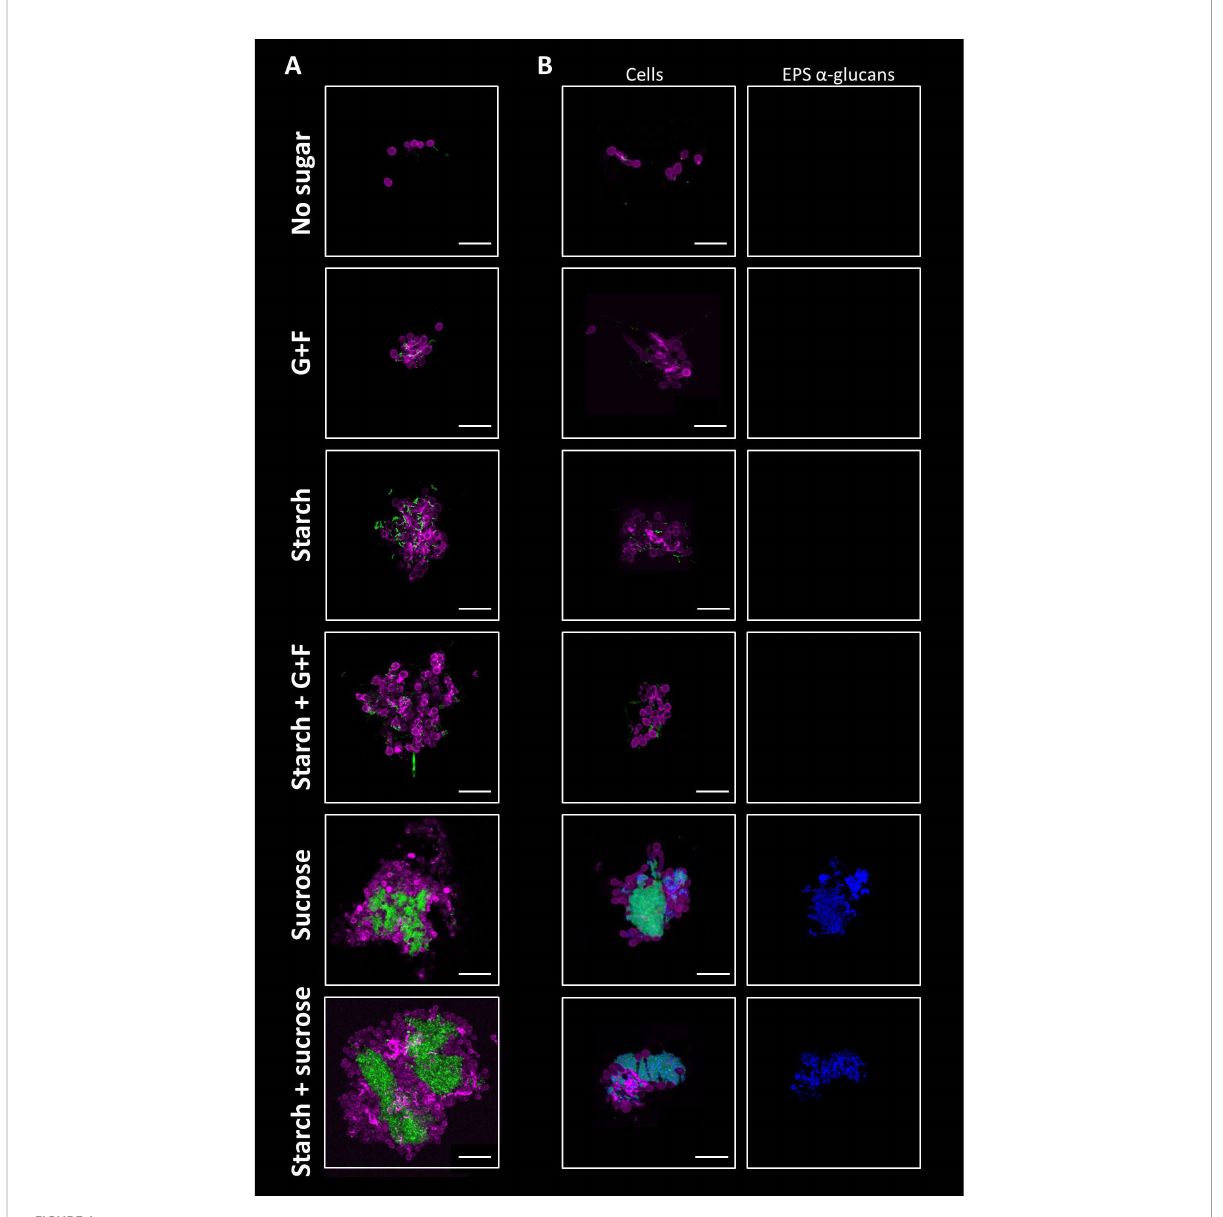
FIGURE 1 Sugar-mediated inter-kingdom aggregates in human saliva. (A) Using fl uorescent staining and confocal microscopy, aggregates formed by S. mutans and C. albicans were found in saliva supplemented with different dietary sugars, which varied in size, structure, and spatial organization depending on the type of sugars. (B) EPS a -glucan matrix were found in sucrose-mediated and starch+sucrose-mediated aggregates, but were not detected in aggregates formed in the presence of other dietary sugars, or no sugar. Green, S. mutans; purple, C. albicans ; blue, EPS a - glucans. G+F: glucose+fructose. Scale bar length=25